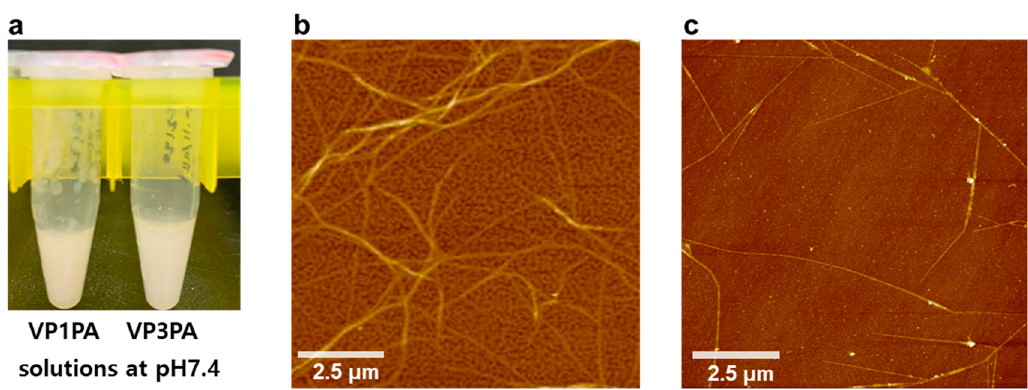
Figure 3. Characteristics of self-assembled epitope peptide amphiphiles. ( a ) Images of mixed solutions. 6 mg/mL in deionized water at the molar ratio of VP1PA:CPA-16 = 6:4 (VP1PA) and VP3PA:CPA-18 = 6:4 (VP3PA) at pH 7.4. Mixed solution of VP1PA:CPA-16 ( b ) and VP3PA:CPA-18